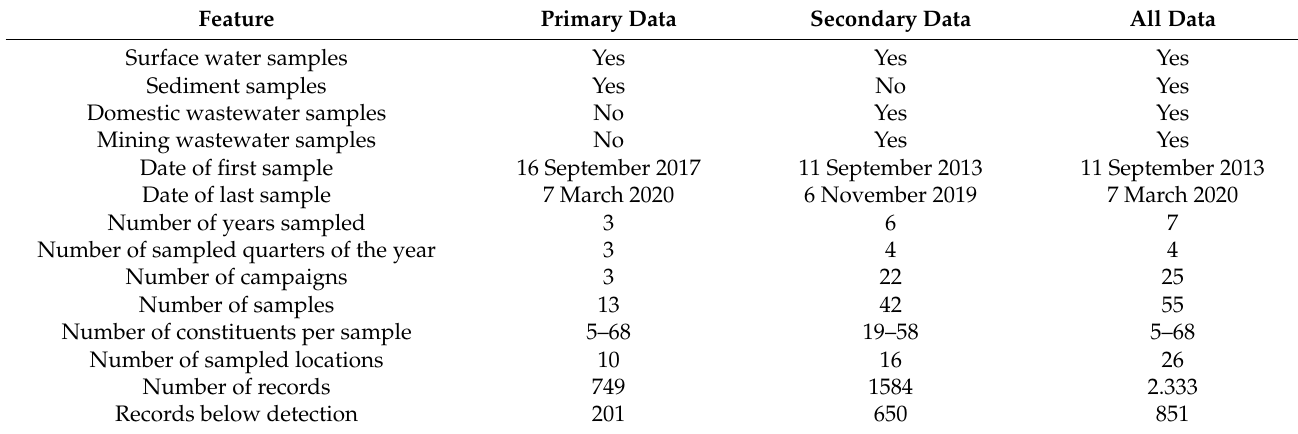
Table 2. Summary of available